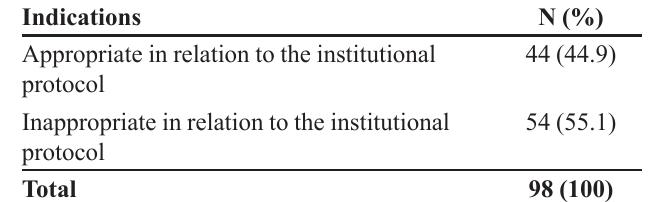
TABLE IV - Analysis of the appropriate therapeutic indications of human albumin according to the institutional protocol